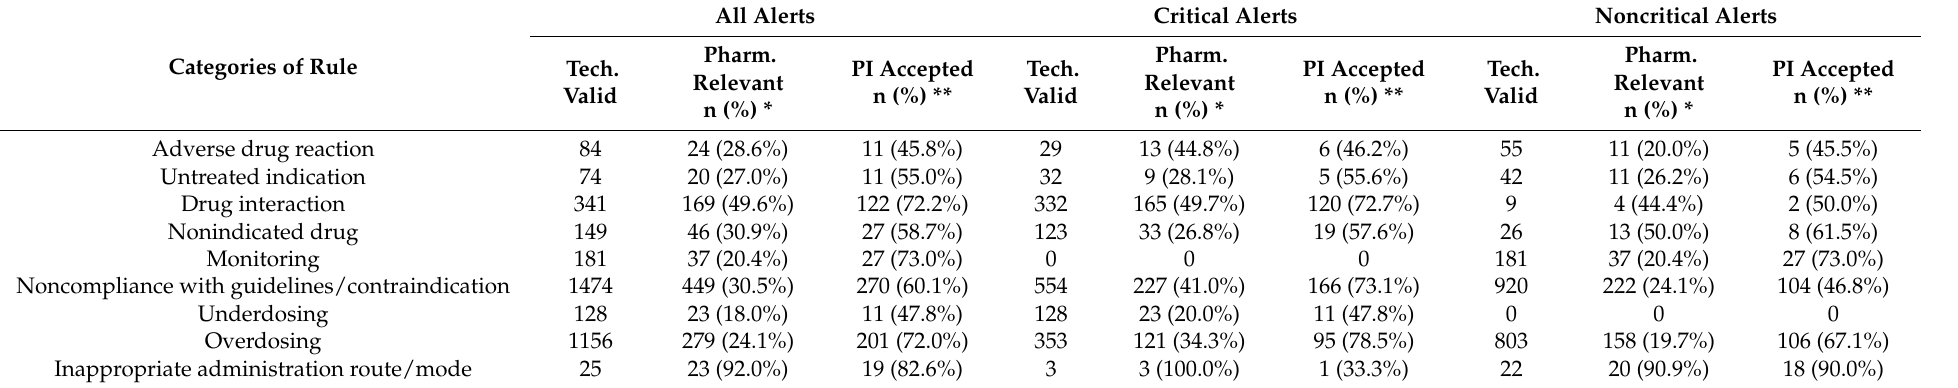
Table 2. Analysis of the categories of rules for all alerts, critical alerts (issued during on-call periods) and noncritical